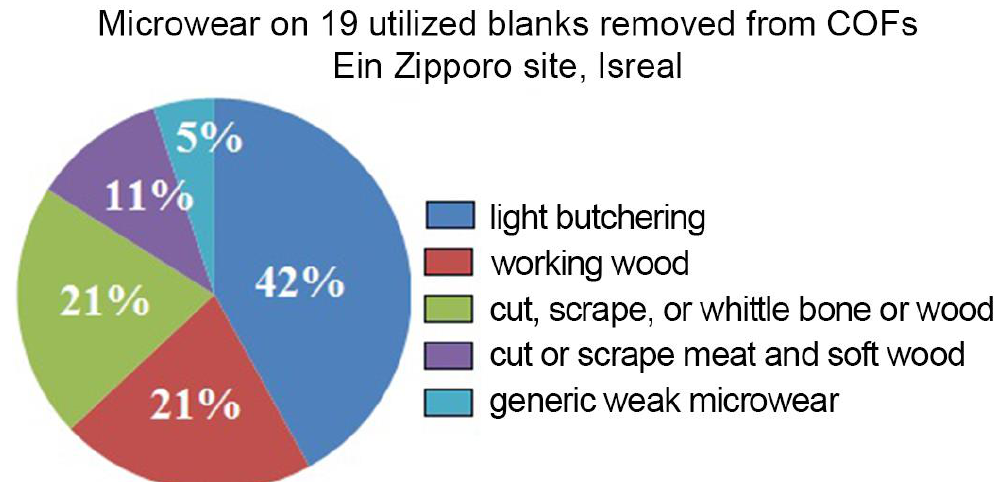
Figure 4. Frequencies of different patterns of microwear on 19 utilized recyled flake blanks struck from cores- on-flakes (COFs) in the sample from the Ein-Zippori site. Microwear on most (42%) is from light butchering (cutting fresh hide and meat and scraping meat off of bones). Four (21%) were used for wood-working, 4 others (21%) were used to cut, scrape, and whittle bone or wood, and 2 (11%) were used to cut or scrape meat and soft wood. One had “generic” microwear traces that could not be associated with a specific